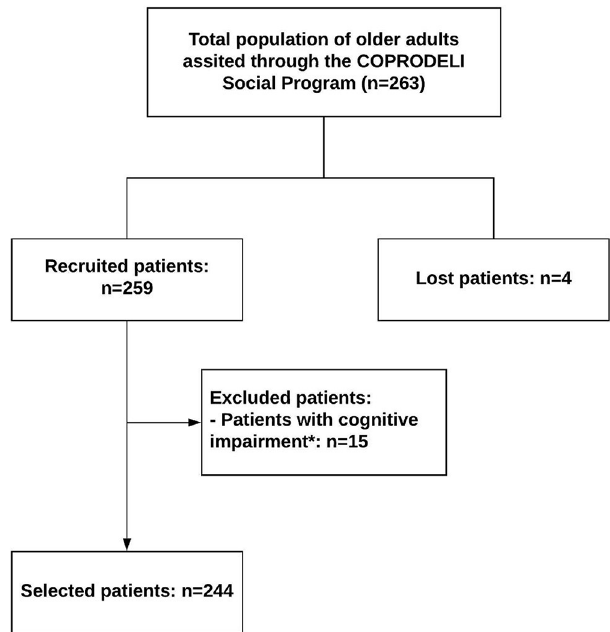
Figure 1. Recruitment and selection process of older adult participants enrolled in the COPRODELI Social Programduringthe COVID-19pandemic,Peru. *Patientwithcognitiveimpairment:score ≤ 23ontheMini-Mental Status Examination